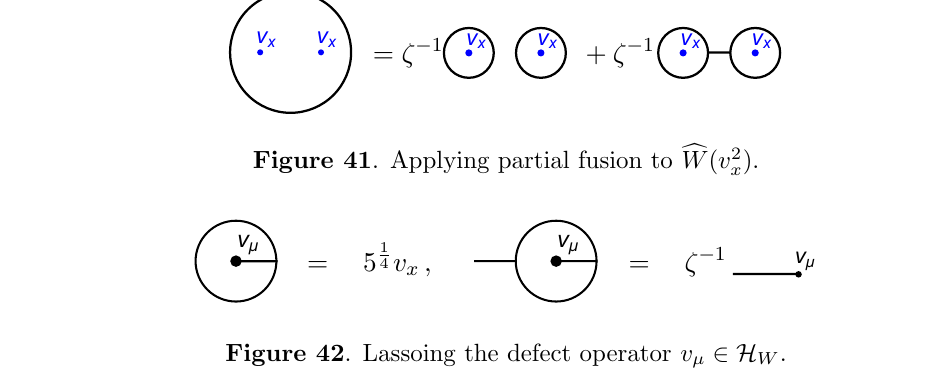
Figure 41 . Applying partial fusion to c W ( v 2